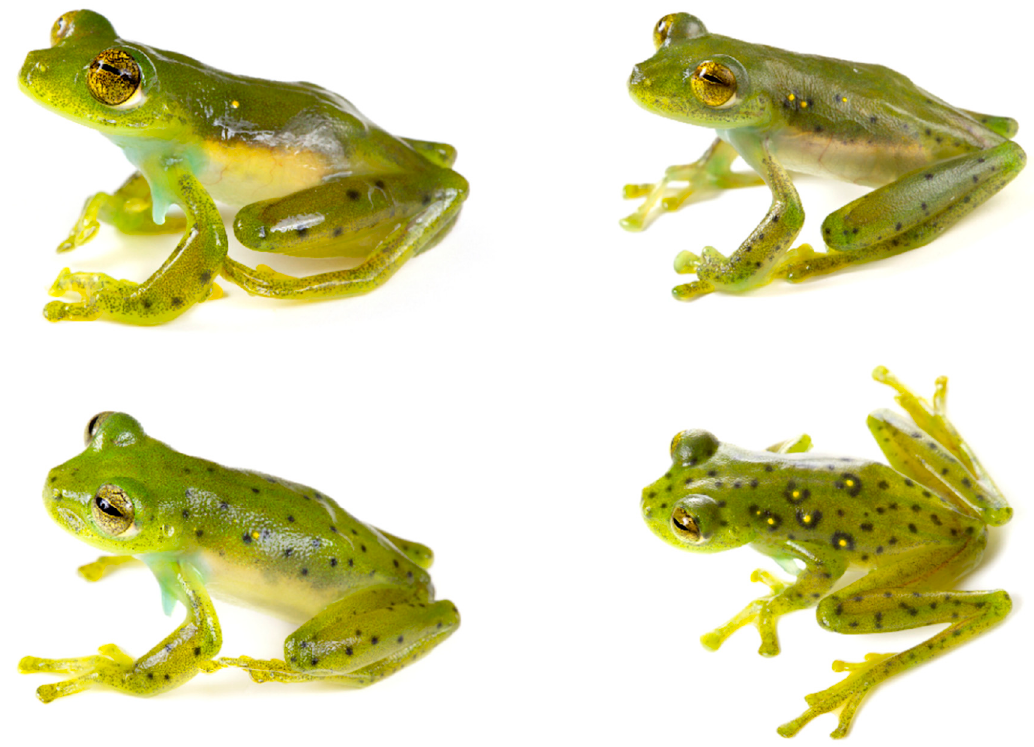
Figure 95. Espadarana prosoblepon in life. Note variation of dorsal patterns. Frogs from Mindo and surroundings, Pichincha province, Ecuador; not collected. Photos by Alejandro Arteaga/Tropical Herping.